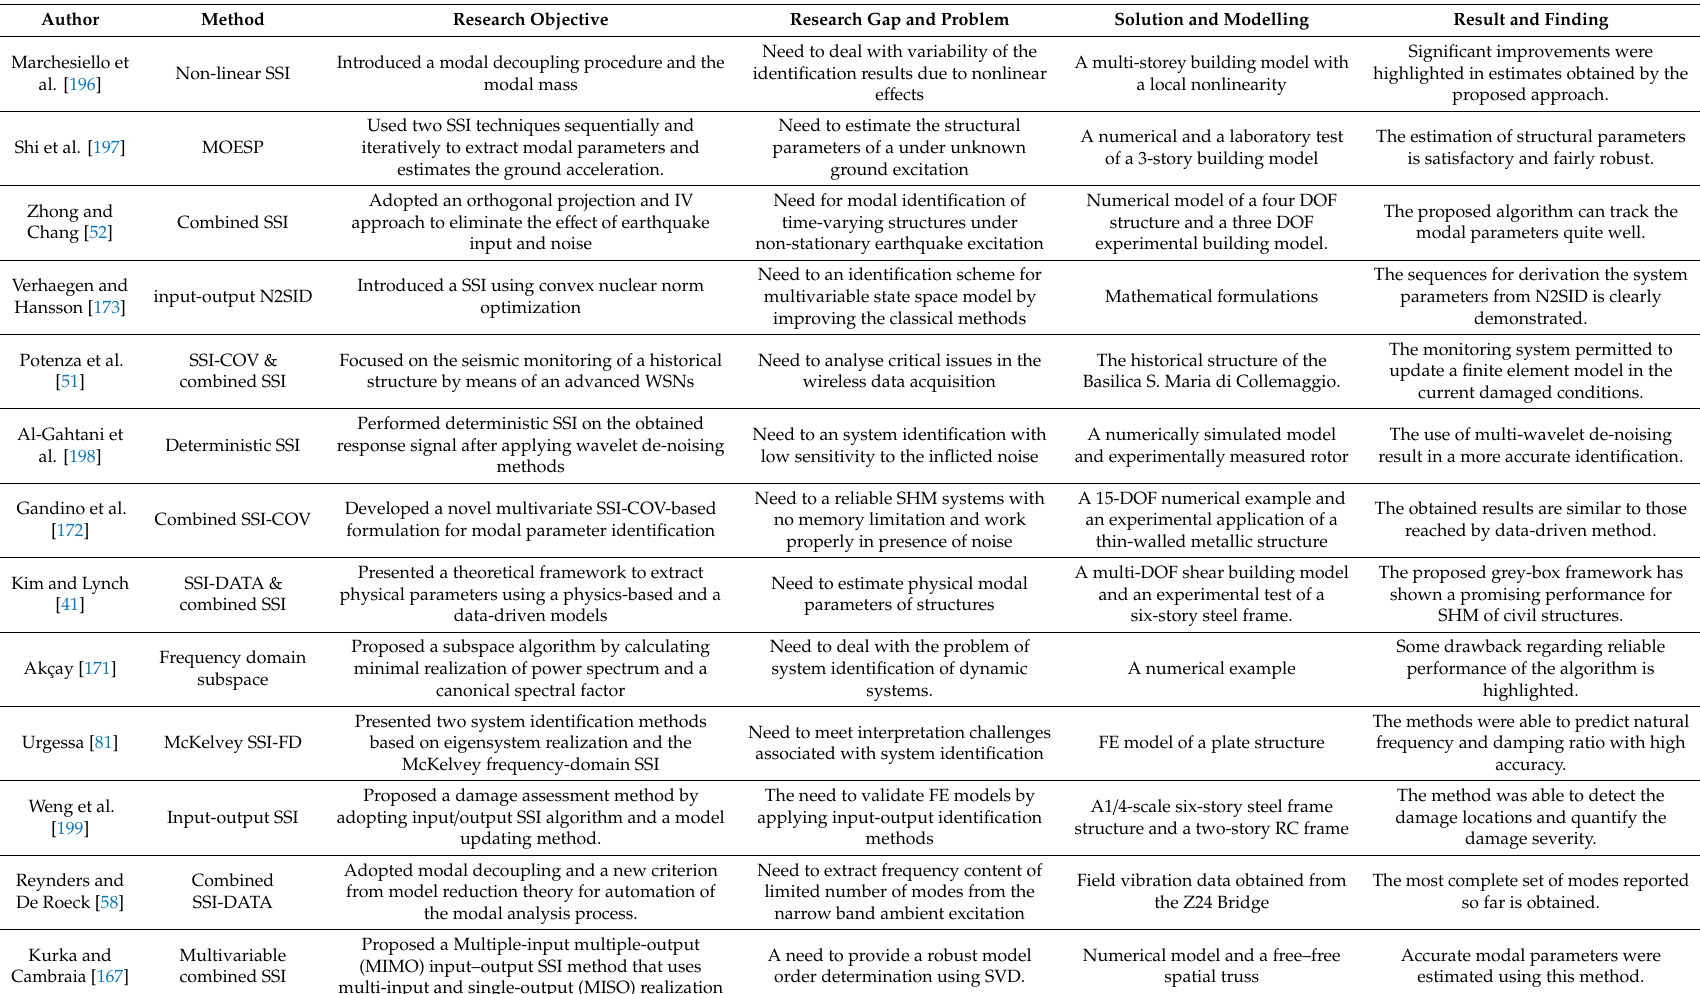
Table A3. Distribution of the papers based on combined SSI